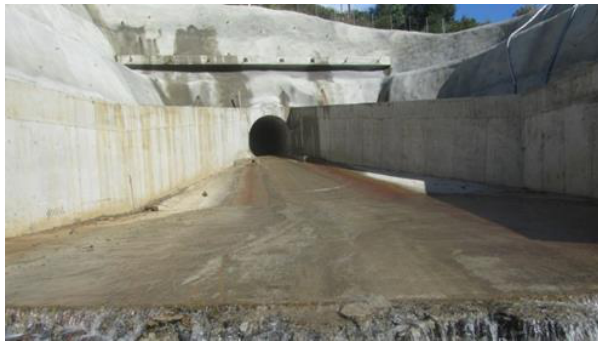
Figure 3. Diversion tunnel exit portal.